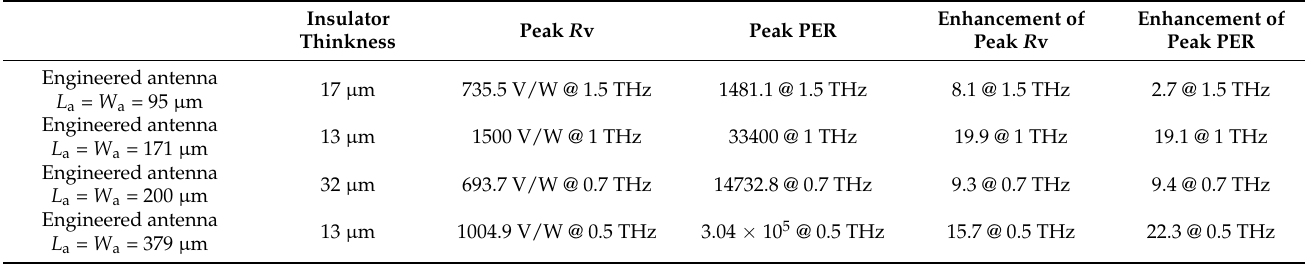
Table 1. Peak Rv, peak PER, and enhancement times of Rv and PER compared to that of the ordinary antenna integrated